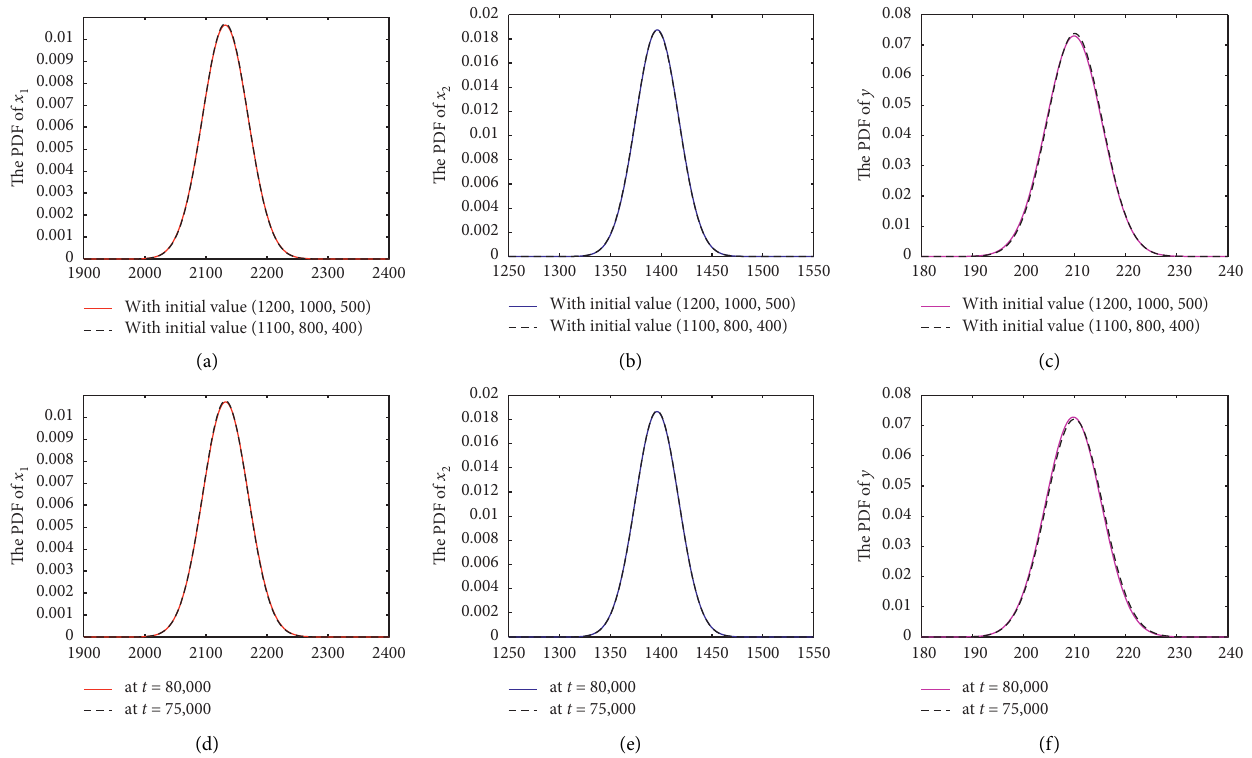
Figure 7: The density based on 10 stochastic simulations for each population. (a)–(c) The density at t � 80 , 000 with different initial value; (d)–(f) the density with initial value ( 1500 , 100 , 500 ) at different time periods (color figure online). (a) PDF of prey x ( t ) , (c) PDF of prey y ( t ) , (d) PDF of prey x x 2